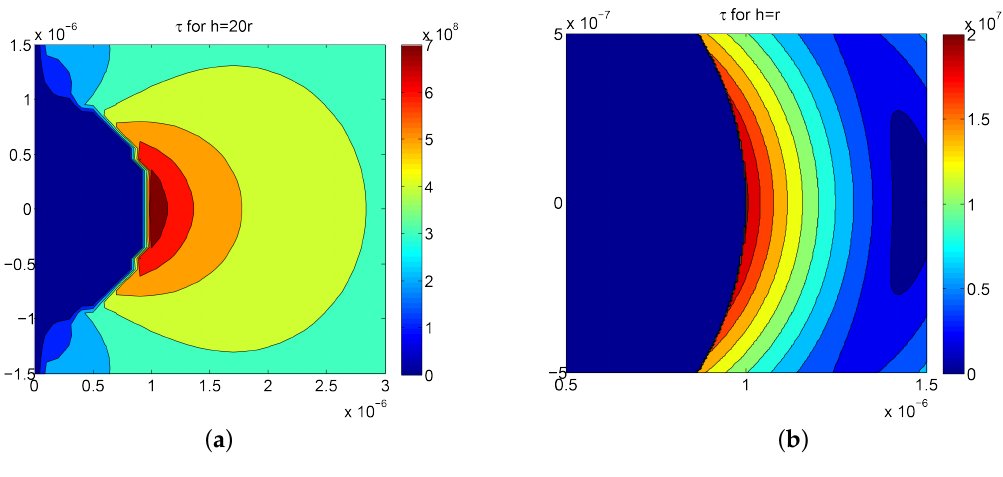
= 20 ( a ); and h = 1 ( b ). r r